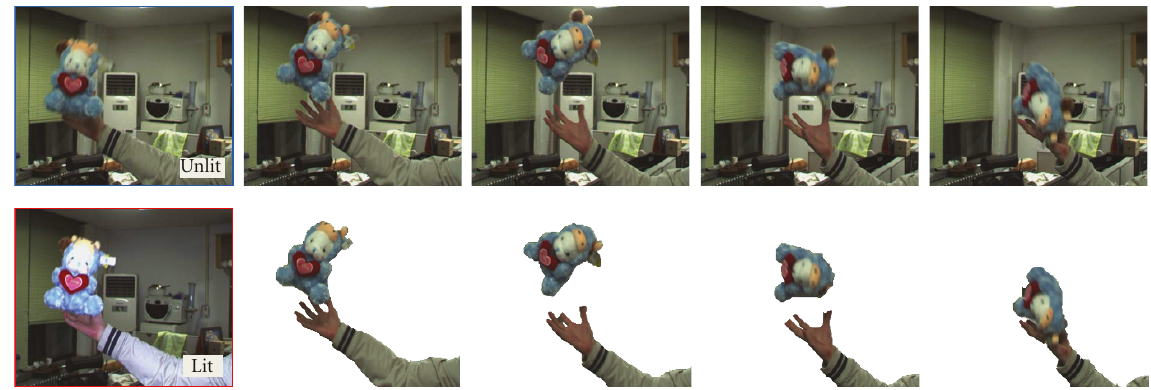
Figure 7: Segmentation of the “Throwing Doll” sequence by the proposed algorithm I. The leftmost column shows a pair of unlit and lit frames, while the other columns show a series of unlit frames and their segmentation results.